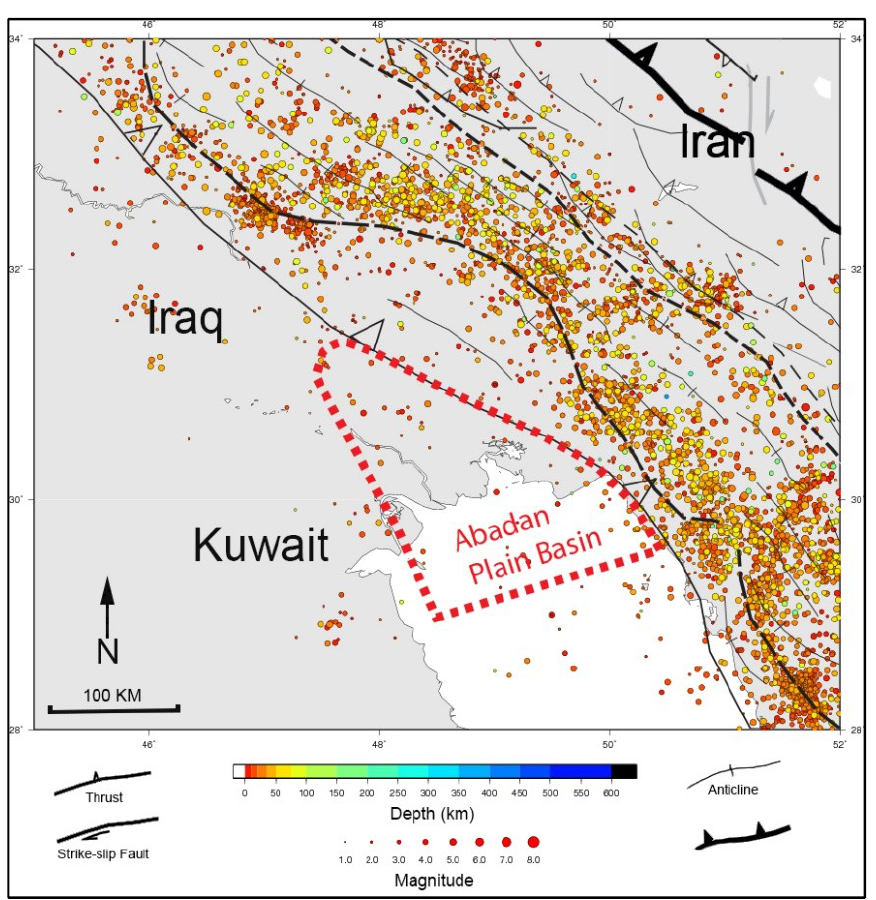
Figure 5. Seismic event map of the Zagros Fold-Thrust-Belt and northern Arabia from 1 January 1900 to 31 December 2016 from Reference [60]. Tectonic structures are from Reference [19]. The intensity of seismic events in the Abadan Plain Basin is lower than those of in the Zagros area.